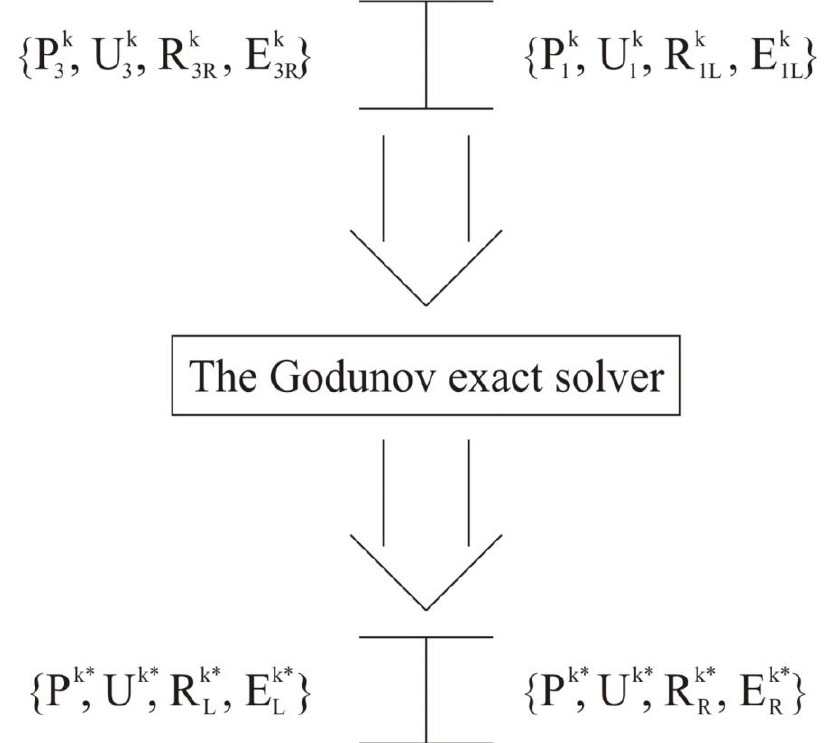
Figure A4. The third Riemann problem.